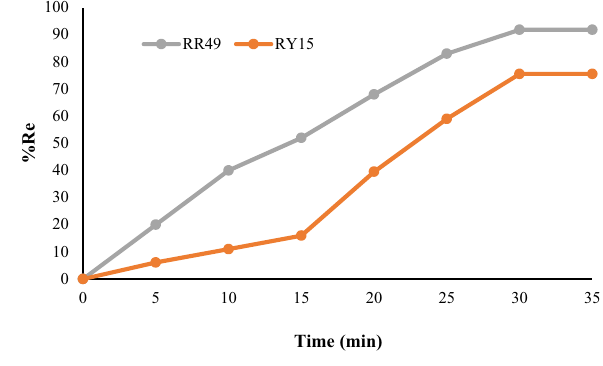
Fig. 5 PZD in relation to pH for iron species in aqueous solution Fig. 6 Effect of time on the %Re of